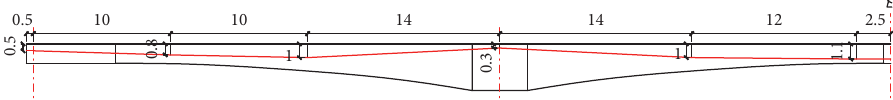
Figure 3: Elevation layout of prestressed tendons (unit: